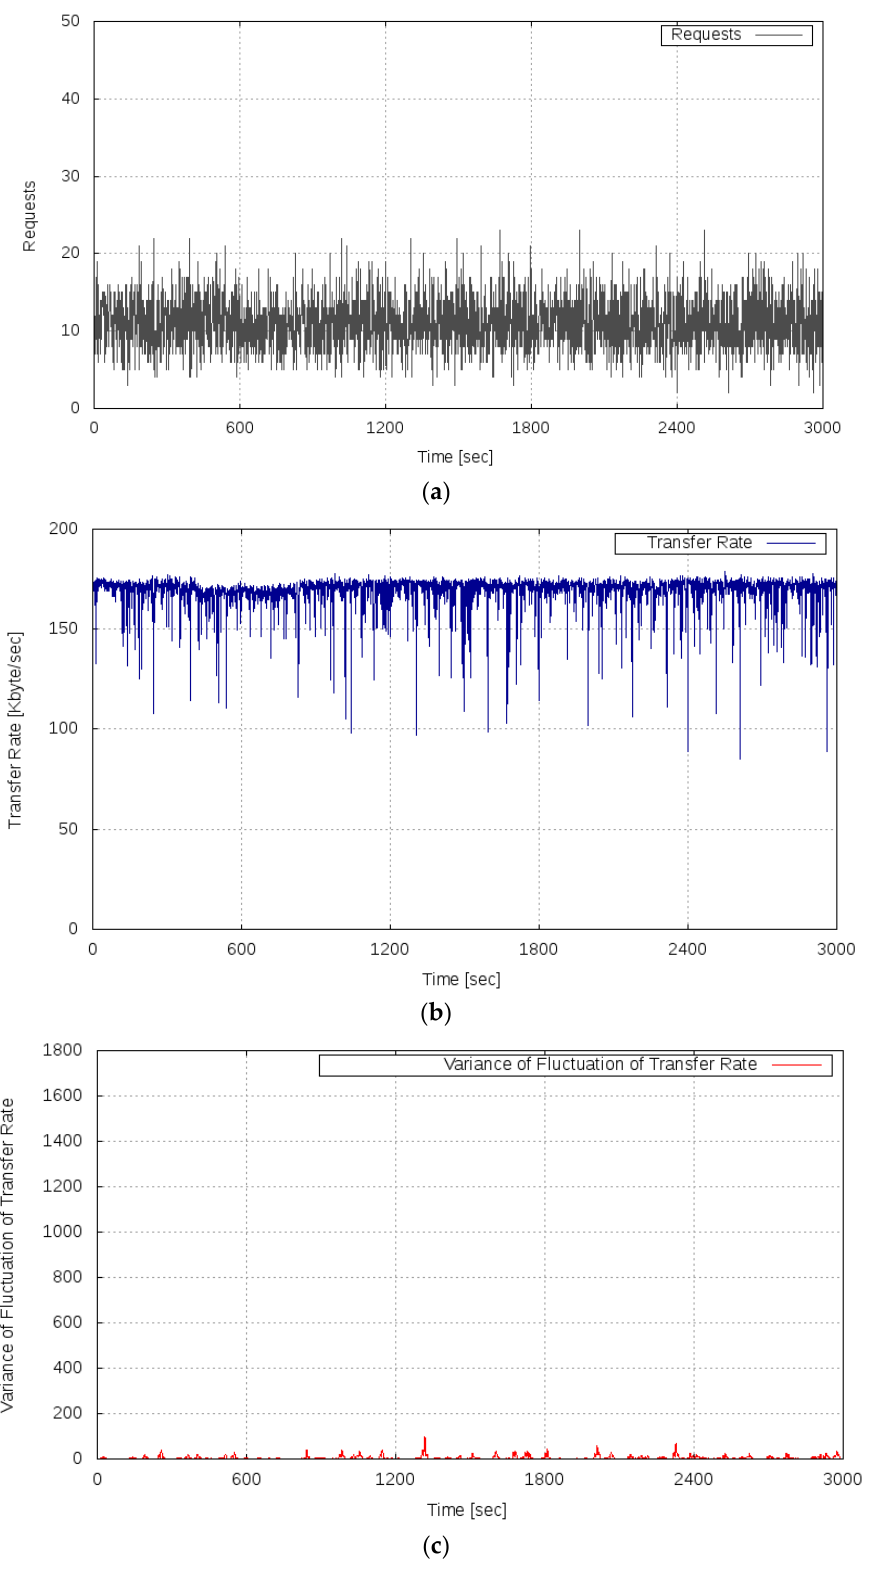
Figure 7. Results of measurements of the normal state of the test bed system; ( a ) server load (requests per second); ( b ) transfer rate; ( c ) variance of the fluctuation of the transfer rate.